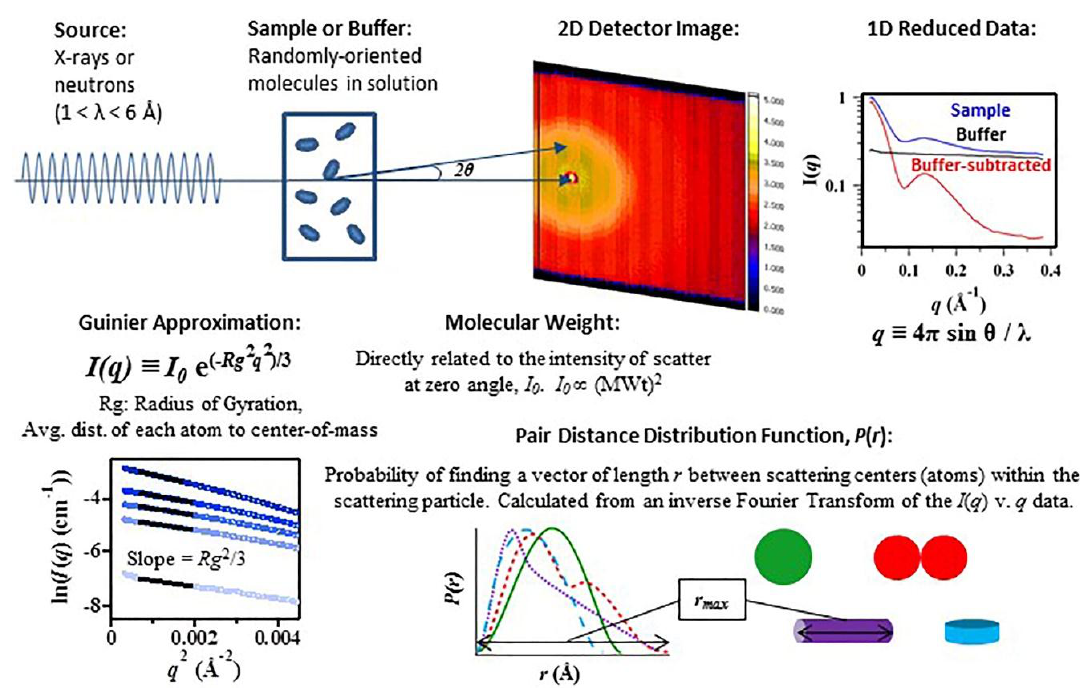
Figure 1. Typical small-angle X-ray and neutron scattering (SAS) experimental set-up and data analysis. I(q) is the intensity of the scattered light as a function of momentum scattering vector, q, as defined above. I(0) is the intensity of the scatter at zero angle and is directly proportional to the square of the molecular weight of the biomolecule (MWt) 2 . R g is the biomolecule’s Radius of Gyration, and is defined as the average distance of each scattering center, atom, from the center-of-mass. P(r) is the pair distance distribution function, calculated as an inverse Fourier Transform of the scattering data and representative of the probability of finding a vector of length r between the atoms within the